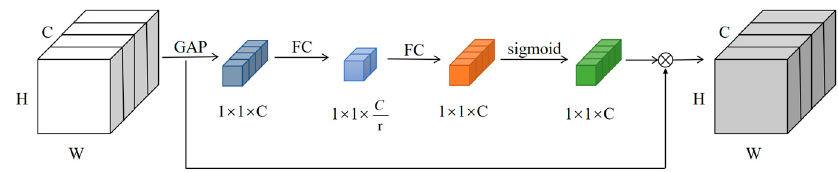
Figure 5. Structure of the SE module.